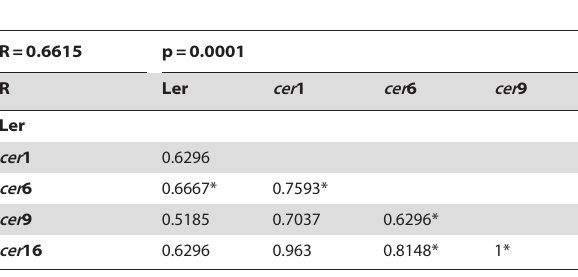
Figure 5. UniFrac distance based hierarchical clustering (UPGMA) of the resident microbiota. The resident community data was extracted from a rarified dataset based on Greengenes phylogeny assignment.